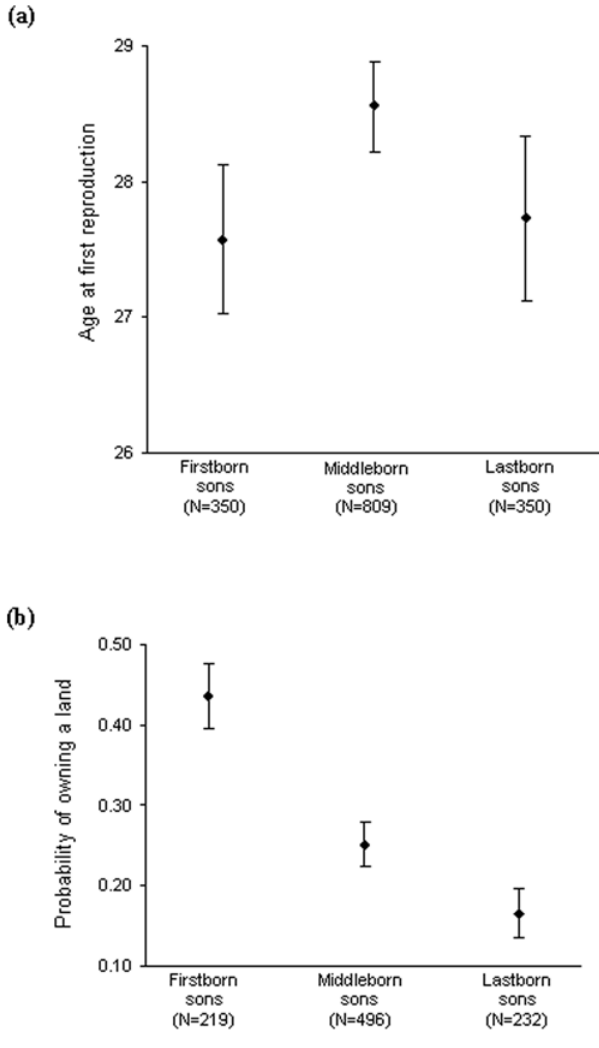
Figure 4. Firstborn sons start reproducing earlier, probably due to their greater access to resources. (a) Age at first reproduction as a function of intra-sex birth-order category: middleborn sons began reproduction later than firstborn sons (F 2,560 =6.54, p =0.002). No such effect was found among sisters (F 2,564 =0.78, p =0.5, not shown in the figure). (b) Proportion of men who owned a land among first-, middle- and lastborn sons: firstborn sons were twice more likely to become landowners ( x 2 2 =25.71, p , 0.0001).